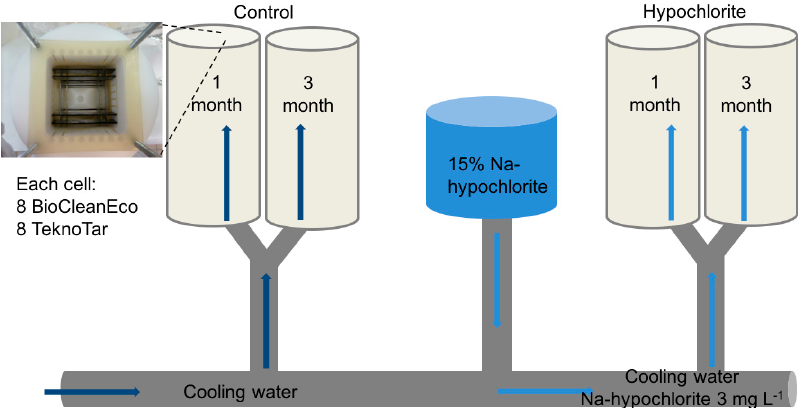
Figure 1. Schematic illustration of experiment setup, not in scale.